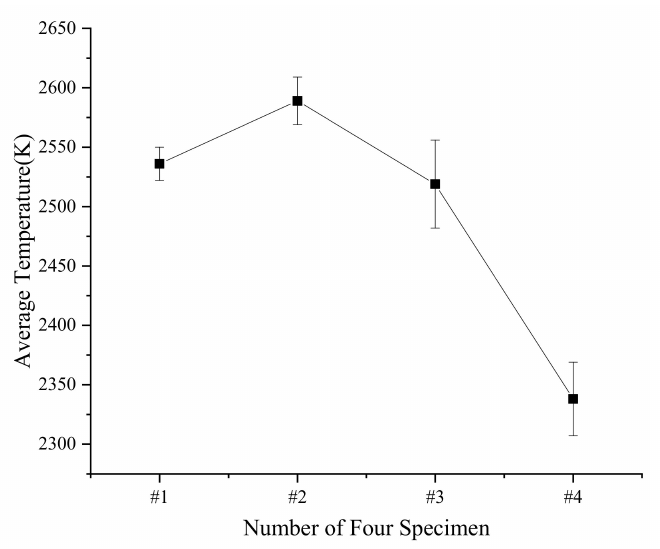
Figure 8. Average temperature and standard deviation of four types of specimens at different drop